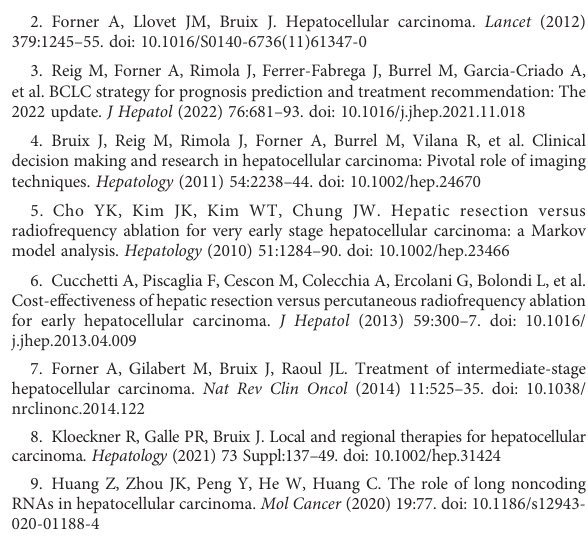
SUPPLEMENTARY FIGURE 1 Flowchart of the study. SUPPLEMENTARY FIGURE 2 HCC single-cell sequencing data from the SMART-seq2 platform. (A) The UMAP plot of different cell types. (B) Ratios of different cell types. SUPPLEMENTARY FIGURE 3 Lasso regression. (A) Cross-validation for tuning parameter selection in lasso regression. (B) Validation of tuning parameter selection by lasso regression. SUPPLEMENTARY FIGURE 4 Time-dependent ROC curves of (A) training cohort, (B) validation cohort 1, and (C) validation cohort 2. SUPPLEMENTARY TABLE 1 Baselines of patients in two validation